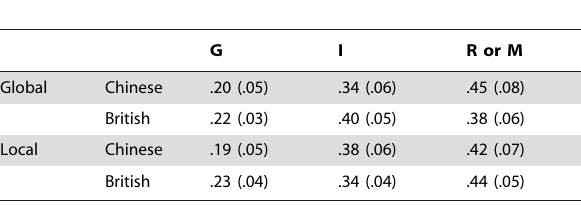
Table 1. Mean Proportions for Each Attribution of Each Group in the Classification Test for Irrelevant Regularity.